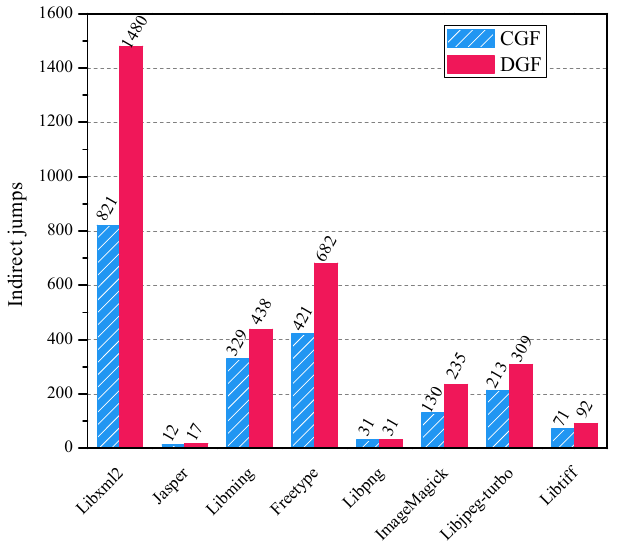
Figure 8. The total number of indirect jumps resolved by two approaches on 8 benchmarks after 20 h. The red bar represents our DGF-based approach (DGF-CFGConstructor), and the blue bar represents the CGF-based approach